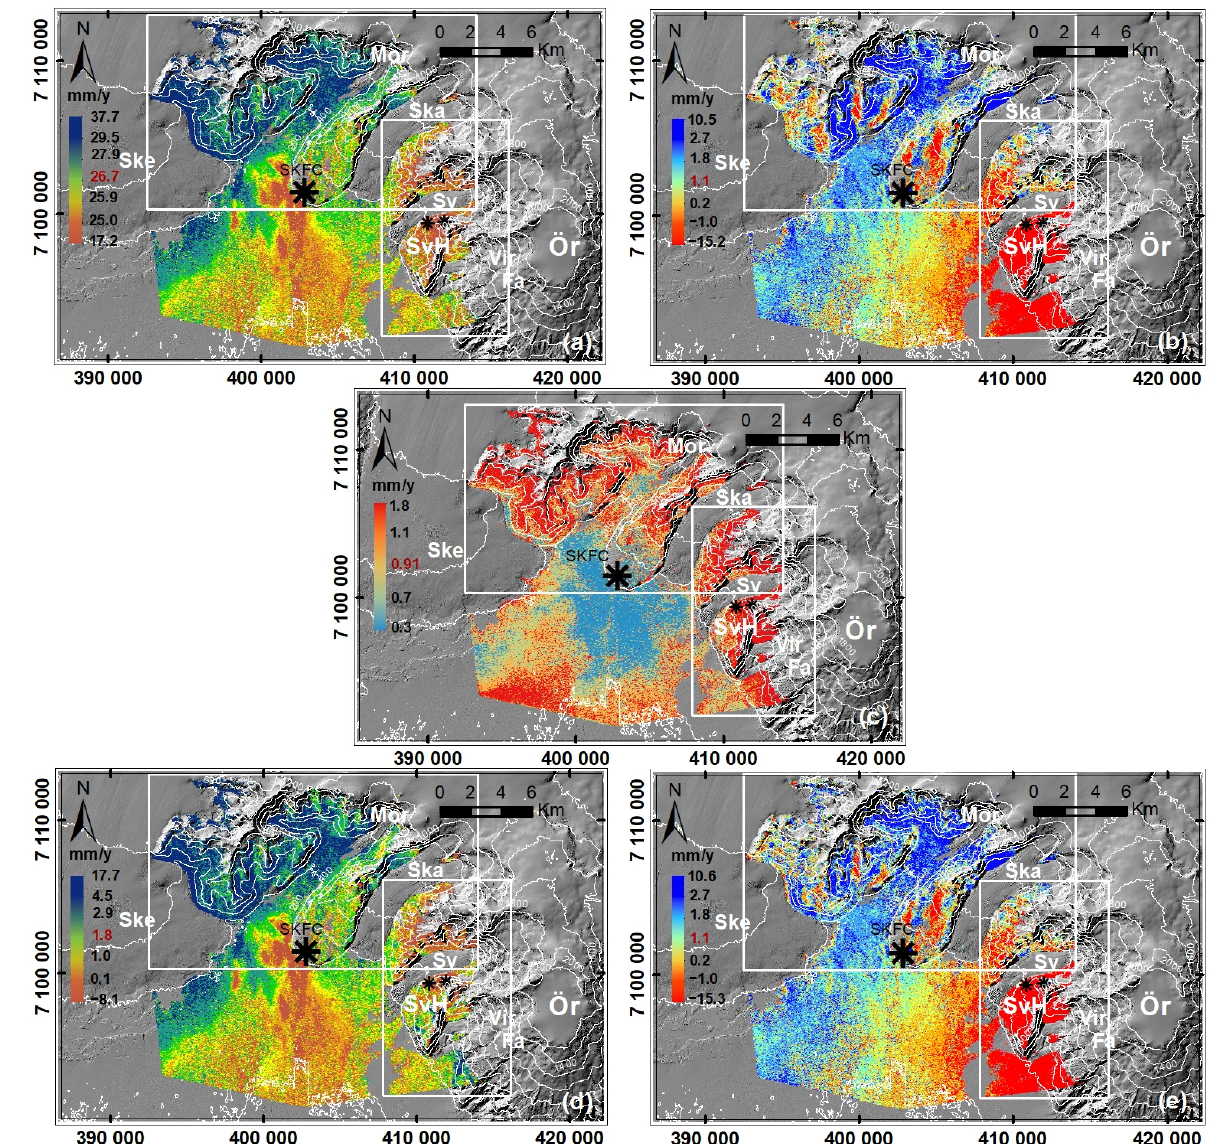
Figure 8. Combined vertical velocity V v , horizontal velocity V h , standard deviation V los estimates, V perp and V slope from the A2D and D2A decompositions: ( a ) vertical velocities; ( b ) horizontal veloc- ities resulting from the first vector decomposition; ( c ) std . V los ; ( d ) velocities perpendicular to the inclined surface V perp ; and ( e ) slope-deformation velocities V slope as a result of the second vector decomposition. The maximum vertical velocities are clustered on the mountain slopes between Skeiðarárjökull and Morsárjökull (upper white rectangle in ( a – e ), parts of these slopes indicate strong movement towards the east direction (blue QPSs in ( b )). Minimum vertical velocities are grouped into two clusters, i.e., on the slopes surrounding Svínafellsjökull and in low-lying areas lower than 200 m a.s.l. (brown QPSs in ( a )). The lowest horizontal velocities are clustered on the south slope of Svínafellsjökull and southwest slopes of Virkisjökull and Falljökull outlet glaciers (lower white rectangle in ( a – e ) and red QPSs in ( b )). The derivation of V perp additionally reveals movements in the direction perpendicular to the slope surface at the Sv í nafellsheiði slope and the slope west of Virkisjökull and Falljökull, which were not detectable in the first decomposition (blue QPSs in ( d )). Abbreviations of major outlet glaciers and slope are presented in white from left to right: Ske—Skeiðar á rjökull; Mor—Mors á rjökull; Ska—Skaftafellsjökull; Sv—Sv í nafellsjökull; SvH—Sv í nafellsheiði slope; Vir—Virkisjökull; Fa—Falljökull;and Ör—Öræfajökull central